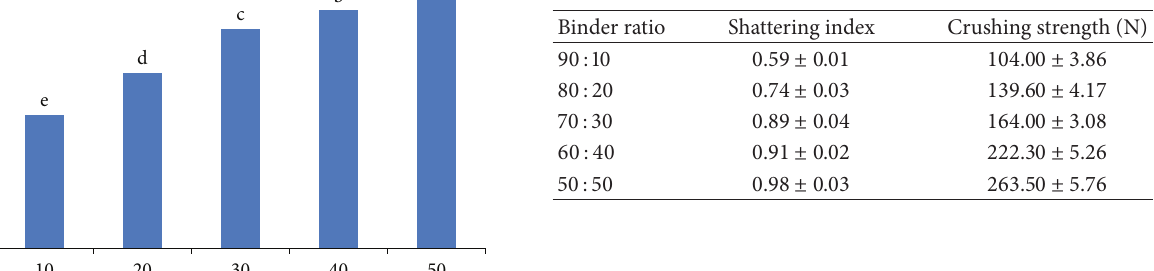
Table 2: Mechanical handling characteristic of